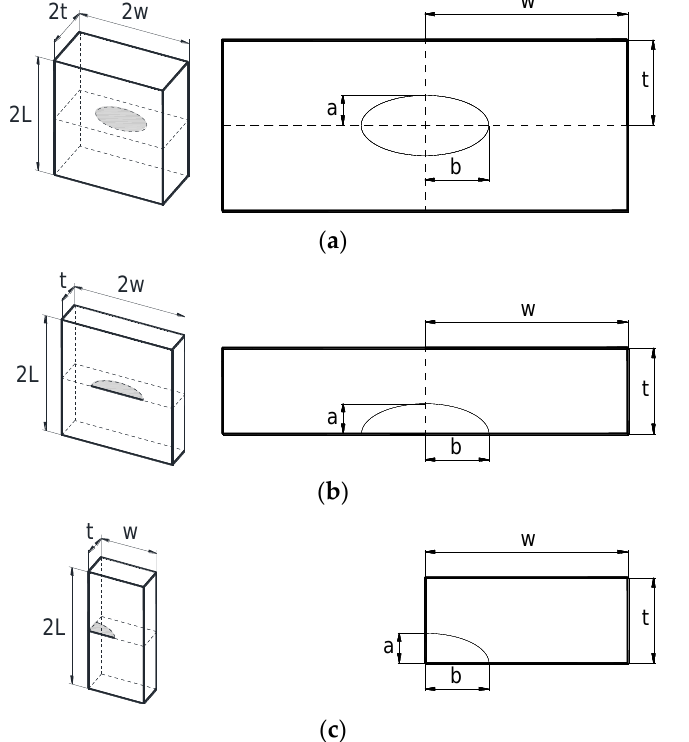
Figure 2. Plate with ( a ) an elliptical embedded crack, ( b ) a semi-elliptical surface crack, and ( c ) a quarter-elliptical corner crack.